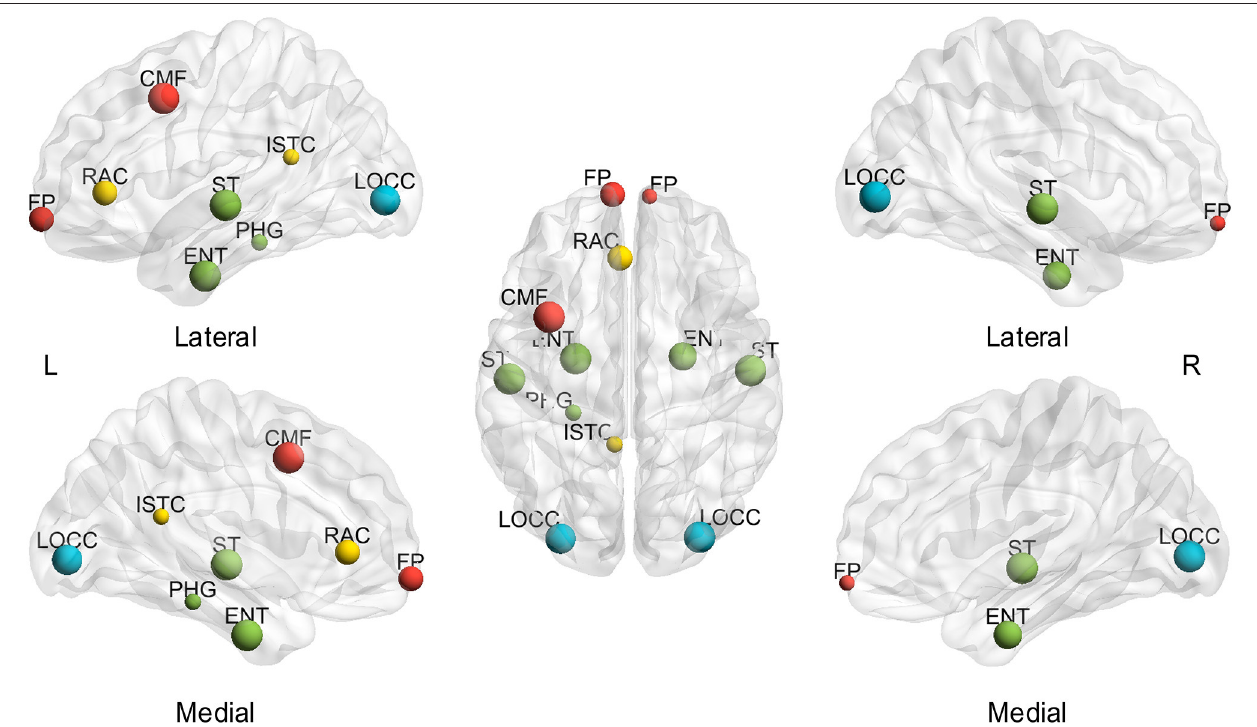
FIGURE 3 | Hubs with a sparsity range exceeding 20%, based on the average of subjects. L, left; R, right; A, anterior; P, posterior; CMF, caudal middle frontal gyrus; ENT, entorhinal cortex; FP, frontal pole; ISTC, isthmus cingulate; LOCC, lateral occipital gyrus; RAC, rostral anterior cingulate; PHG, parahippocampal; ST, superior temporal gyrus. The size of the node represents the proportion of sparsity; the largest node denotes 100% of the proportion. The different color of nodes denotes the different lobes: red-frontal lobe; green-temporal lobe; blue-occipital lobe; yellow-cingulate.